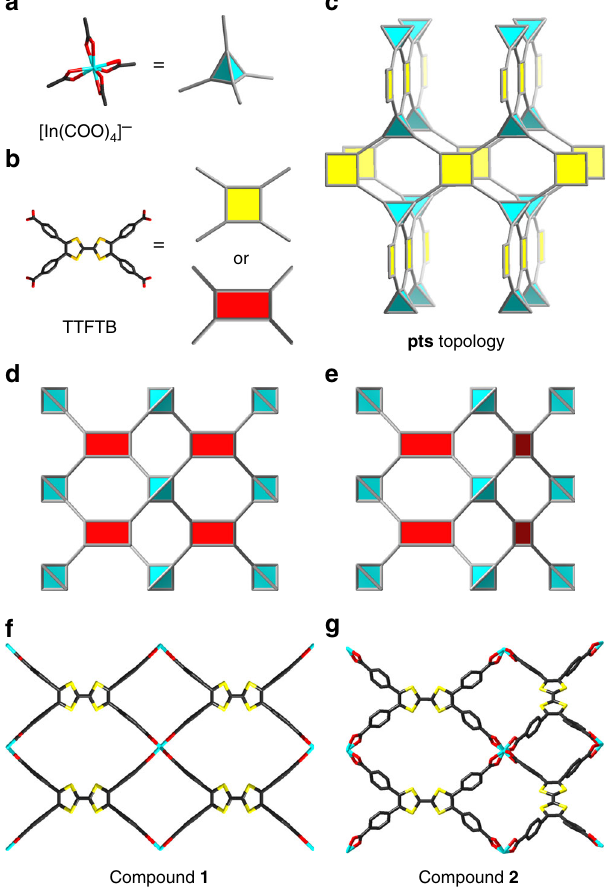
Fig. 1 Topology-guided design of compounds 1 and 2 . a [In(COO) 4 ] − inorganic building unit as a tetrahedral node; b TTFTB organic linker as a square planar node; c pts topology; d , e two networks derived from pts topology; f , g structure of compounds 1 and 2 . Color scheme: In, cyan; O, red; C, gray; S,